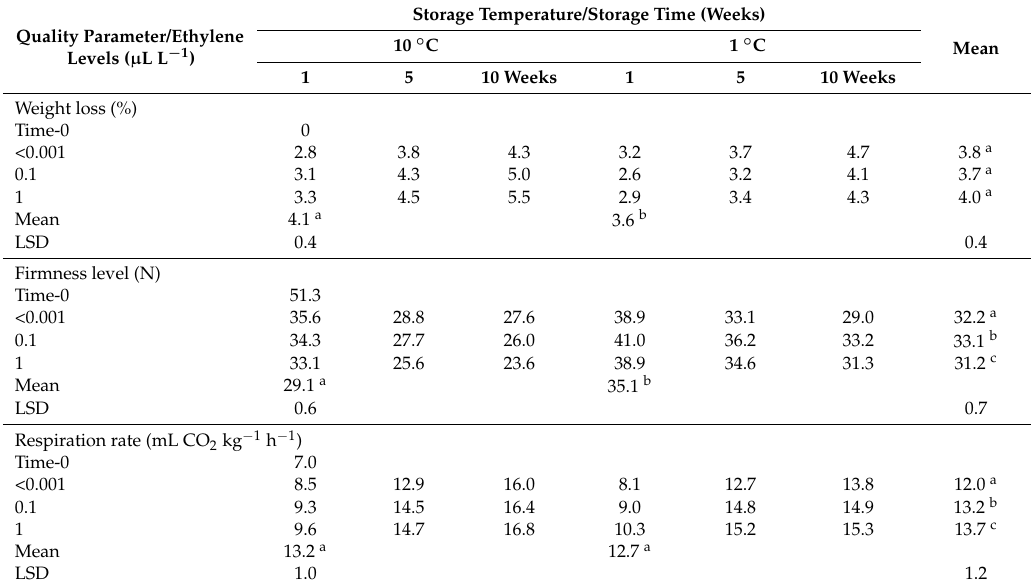
Table 3. Weight loss, firmness and respiration rate of Navel oranges stored at 1 and 10 ◦ C. Quality Parameter/Ethylene Levels ( µ L L − 1